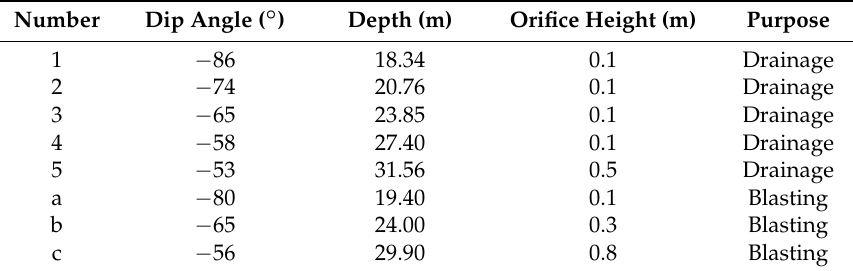
Figure 9. Borehole bottom position of controlled presplitting blasting holes. Table 3. Drilling parameters of controlled presplitting blasting.